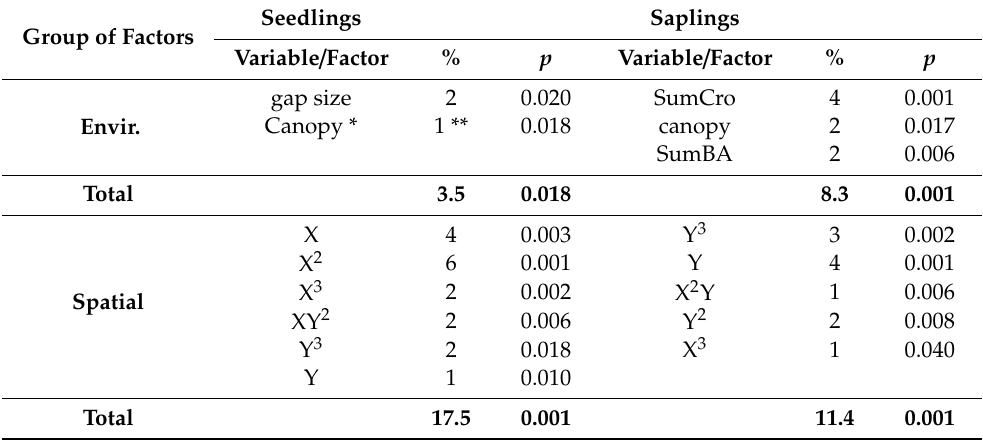
Table 6. The relative amount of varation of tree species composition explained by selected environmental and spatial factors (forward selection) in the RDA analysis in the old-growth forest Sitno. Group of Factors